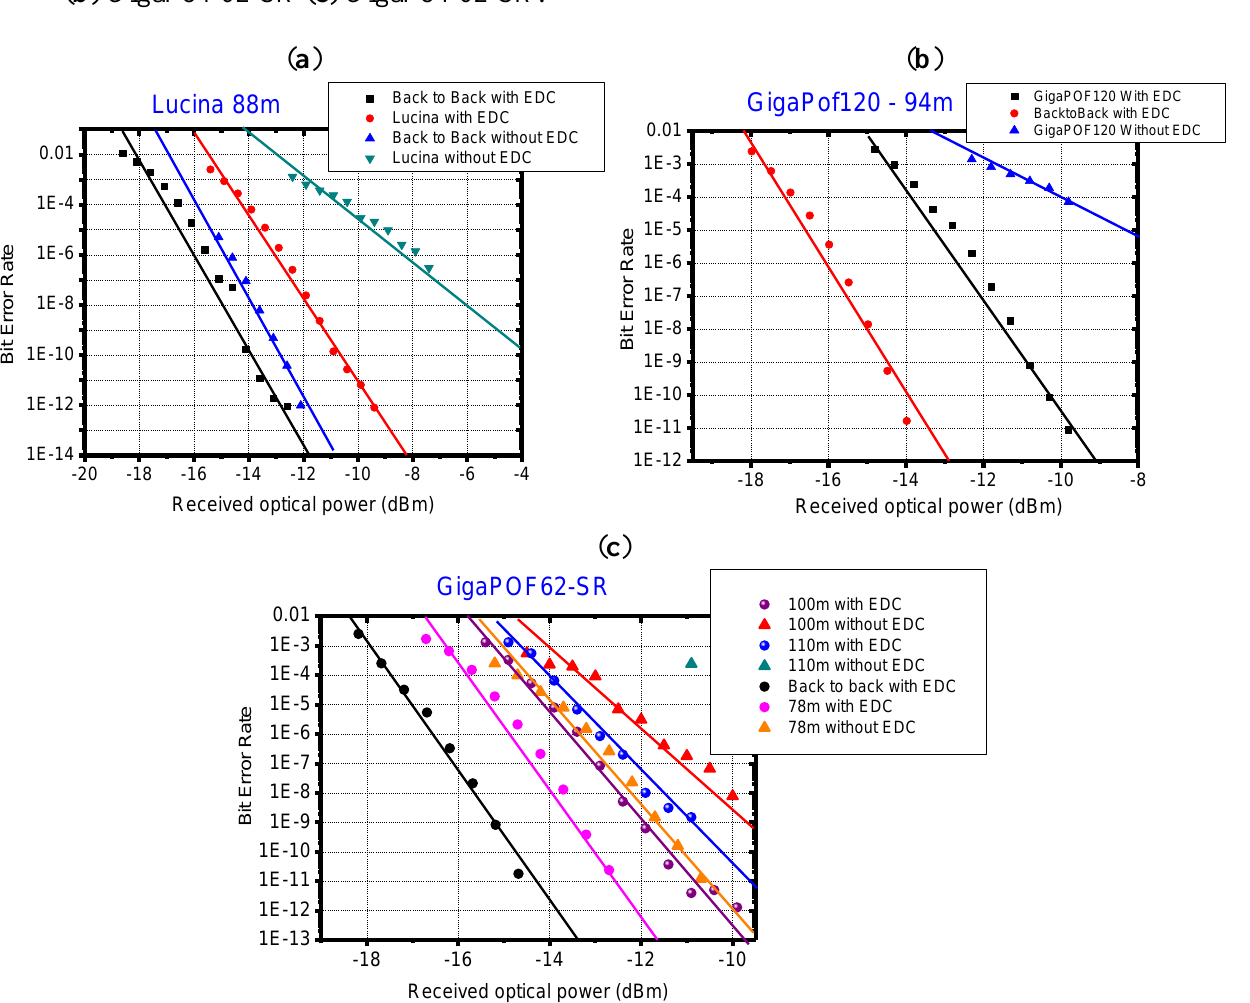
Figure 16. BER measurement as a function of the received optical power: ( a ) Lucina ( b ) GigaPOF62-SR ( c )